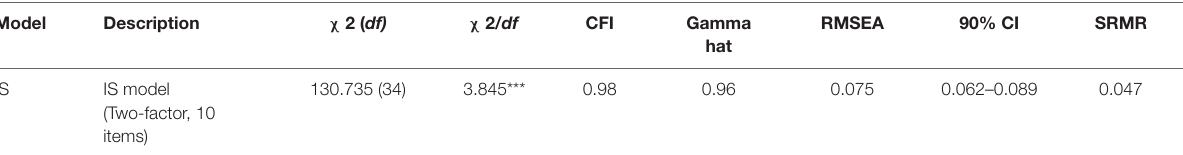
TABLE 3 | Model fit indices of institutional support model.